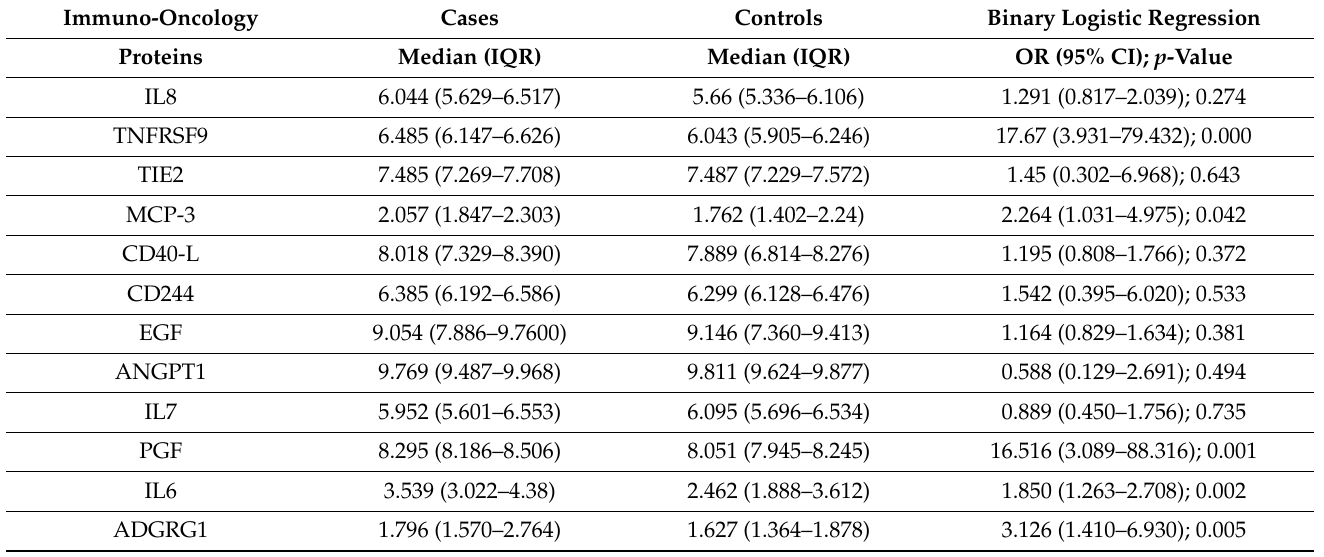
Table 1. Immuno-oncology panel: result of descriptive analysis, and binary logistic regression against the